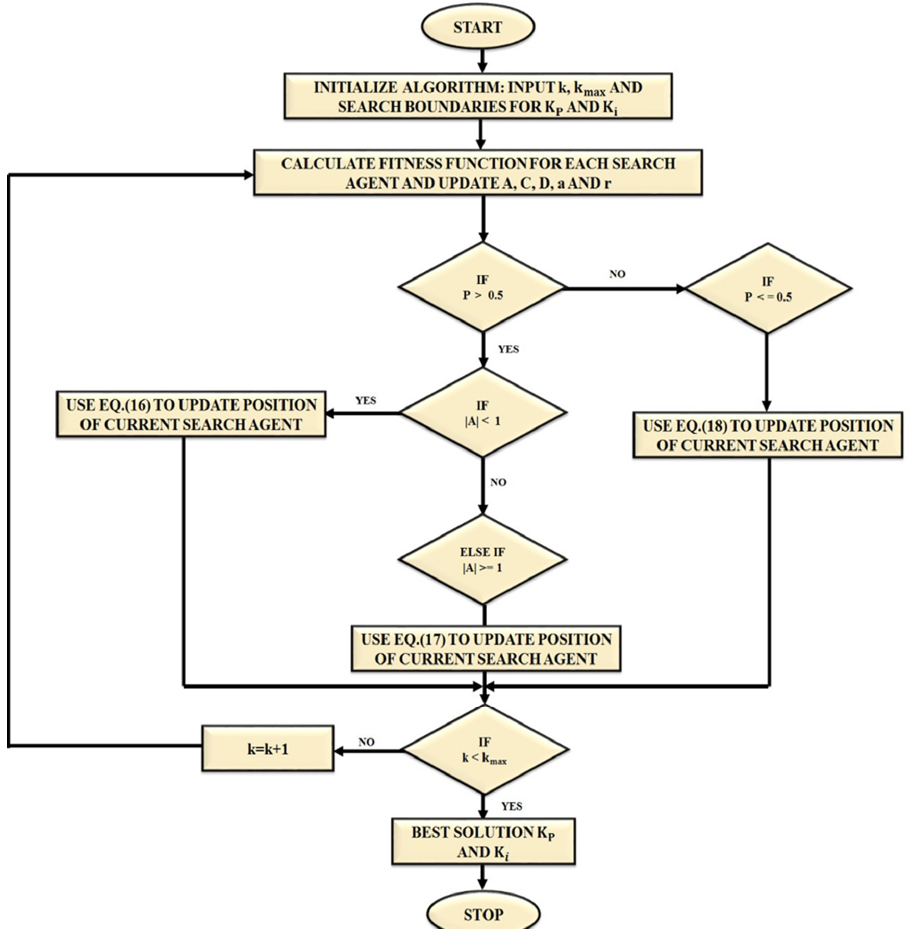
Figure 5. Flowchart for tuning the controller parameters using a whale optimization algorithm.